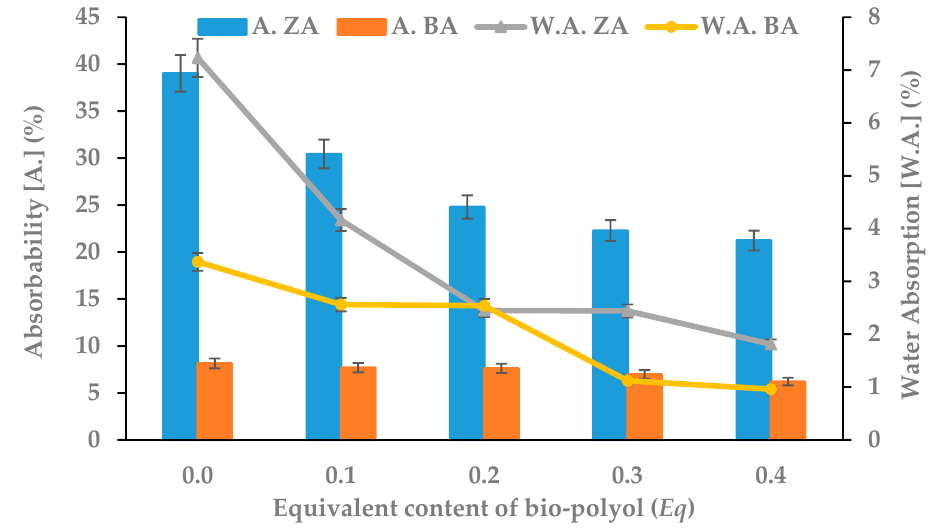
Figure 4. Dependence between bio-polyol content, absorbability (A.) and water absorption (W.A.). Obtained results were in the range of values assumed for this type of polyurethane materials.